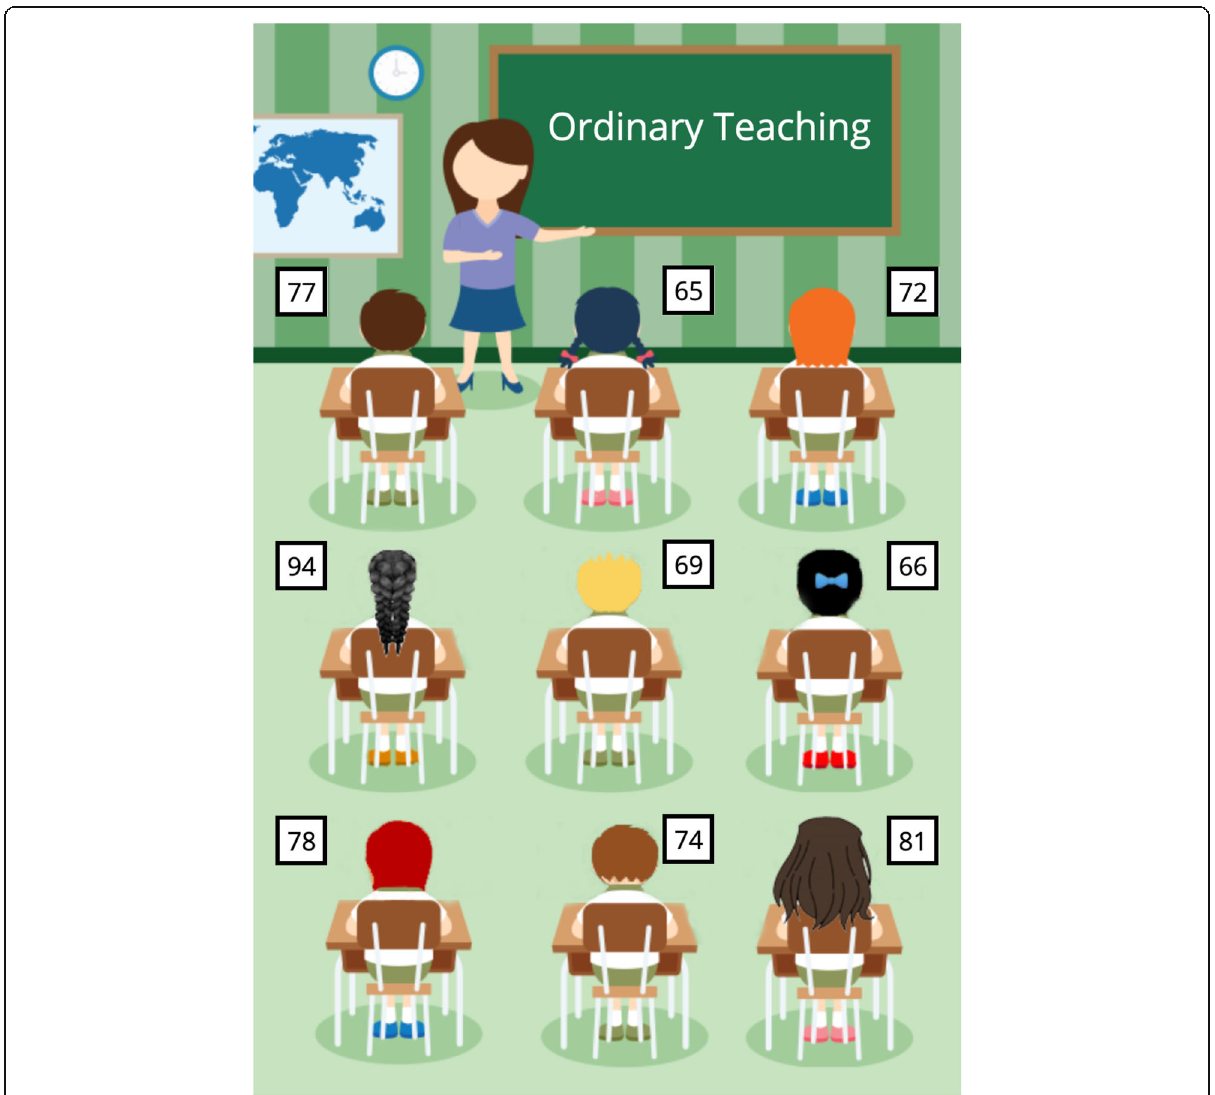
Fig. 9 An example of a no-cue trial from Experiment 5 showing the simulated classroom